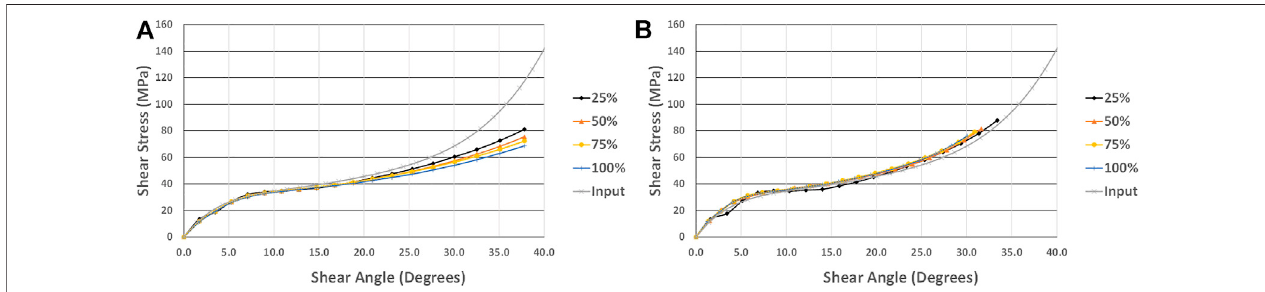
Frontiers in Materials |